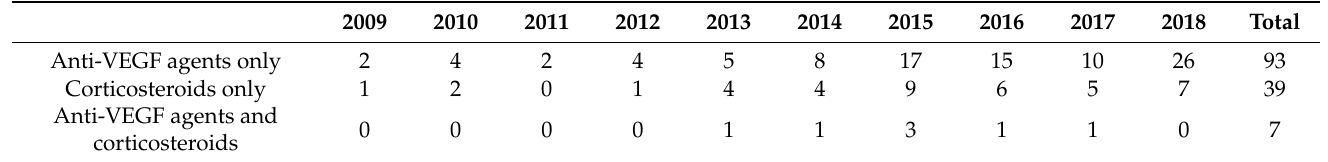
Table 1. Number of pregnant women treated with anti-VEGF or corticosteroid IVTs in France